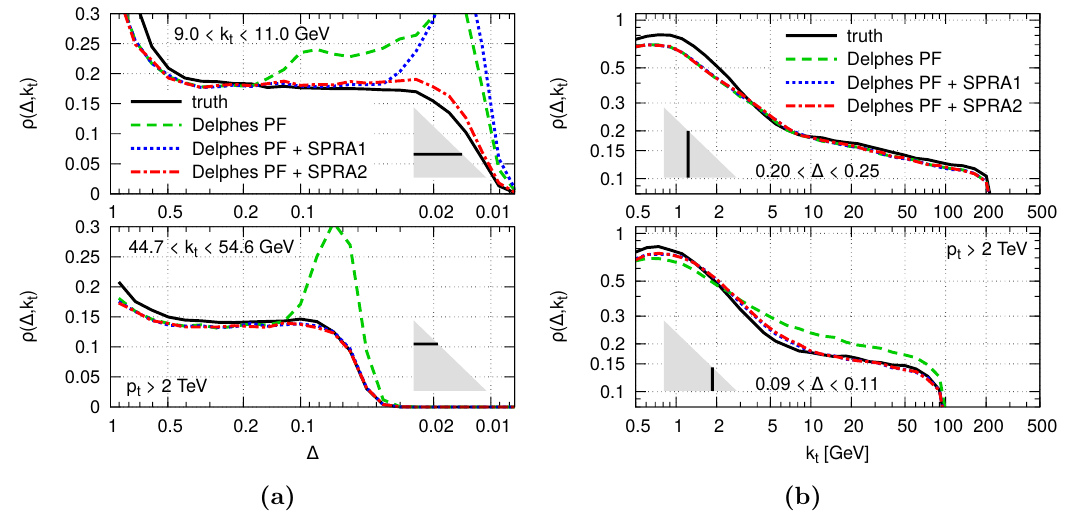
Figure 19. Lund-plane slices comparing the truth result to Delphes PF with and without the SPRA rescalings. The slices are shown at (cid:12)xed k t as a function of (cid:1) (left) and at (cid:12)xed (cid:1) versus k t (right). The artefacts visible in the top-left plot at scales of the hadronic ((cid:1) (cid:24) 0 : 087) and electromagnetic ((cid:1) (cid:24) 0 : 0174) calorimeters are well brought under control by the SPRA1 and SPRA2 rescalings respectively. The generation and selection of jets is as described in section 3.4, using the